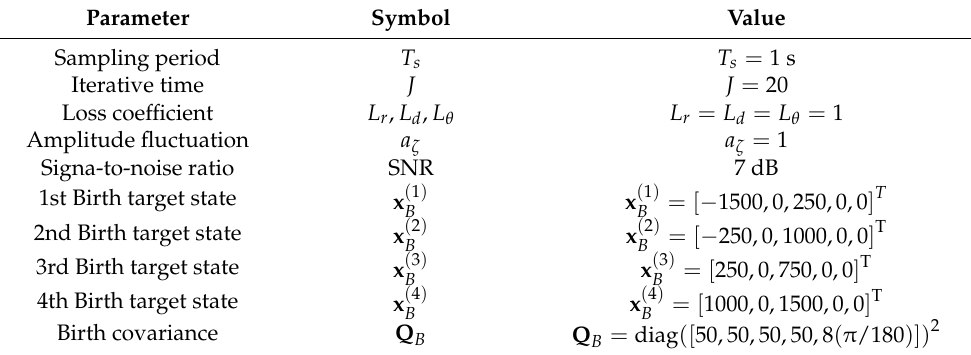
Figure 5. The estimated track of multiple targets for a single MC run. The colored dots represent the estimated position. Table 2. The main parameters of the